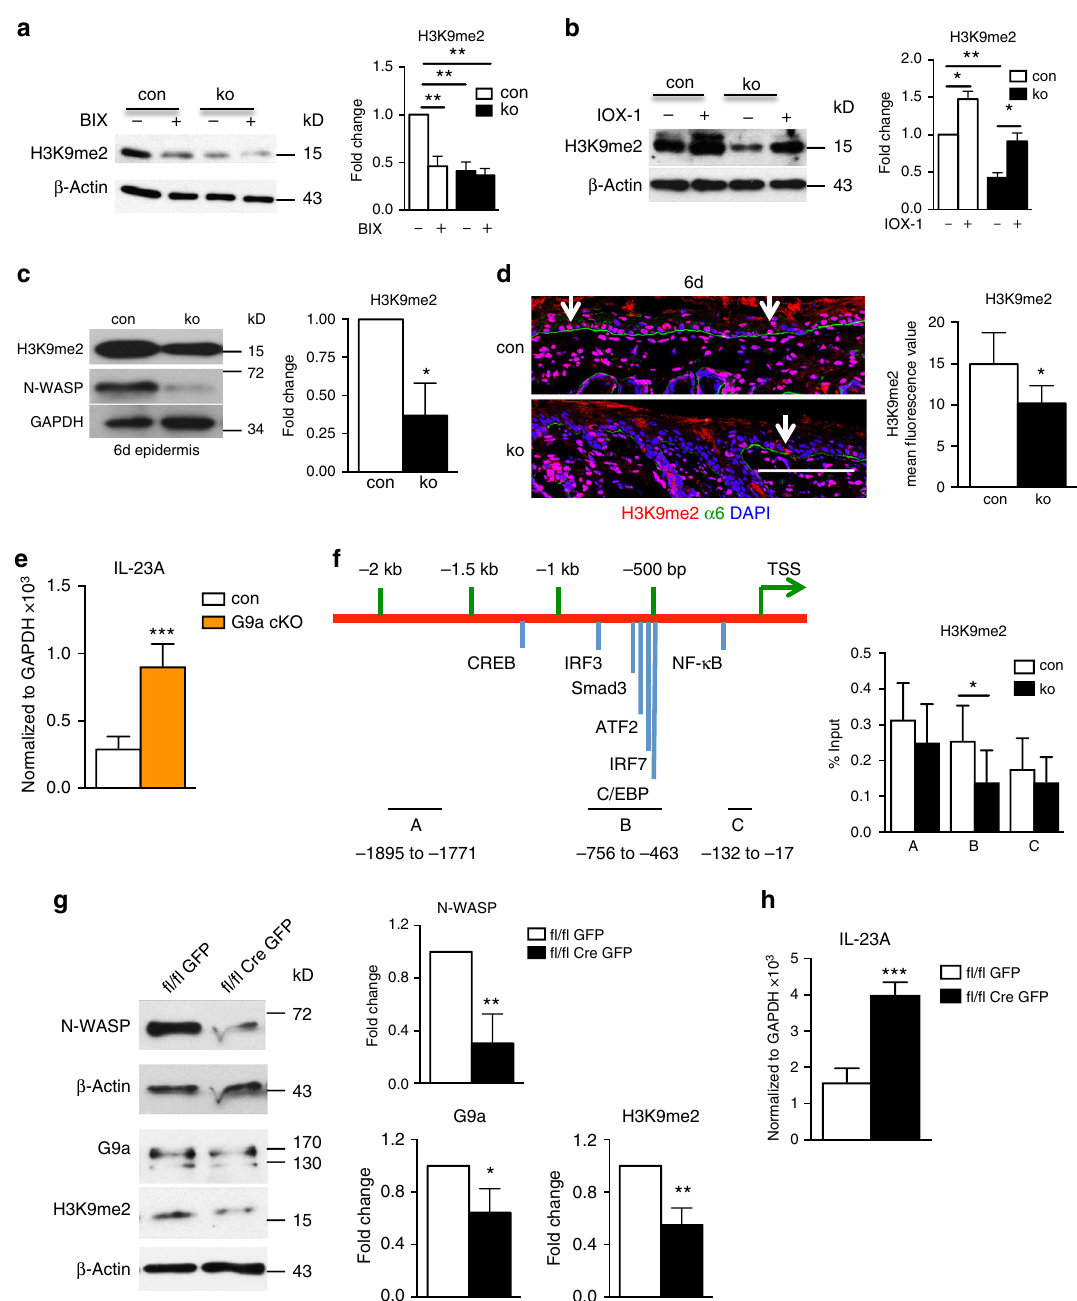
Fig. 7 N-WASP represses IL-23p19 expression in keratinocytes by regulating H3K9 dimethylation. a , b Immunoblot analysis of H3K9me2 level in con and ko primary keratinocytes treated with BIX01294 ( a ) or IOX-1 ( b ) for 24 h ( n : 3/3, mean ± SD, one-way ANOVA, with Tukey ’ s multiple comparisons). c Immunoblot for H3K9me2 in epidermis of 6-day-old mice ( n : 3/3, mean ± SD, two-tailed unpaired t -test). d H3K9me2 IF of back skin of 6-day-old mice ( n : 3/3). Scale bar: 100 µ m. e qRT-PCR analysis of IL-23A mRNA expression in sorted interfollicular epidermal keratinocytes from con and G9a knockout. All normalized to GAPDH ( n : 4/4, mean ± SD, two-tailed unpaired t -test). f ChIP of primary keratinocytes for H3K9me2 with qPCR for indicated regions of IL- 23 promoter ( n : 7/7, mean ± SD, two-tailed unpaired t -test). g , h Primary N-WASP fl / fl cells lentivirally transduced with GFP or Cre-GFP were analyzed by western blot for indicated genes ( g ) and by qRT-PCR for IL-23A expression ( h ; n : 4/4, mean ± SD, two-tailed unpaired t -test; * p ≤ 0.05; ** p ≤ 0.01; *** p ≤ fraction (33% ± 2%), while the soluble nuclear fraction contained only low amounts (2% ± 0.5%) (Fig. 8f).